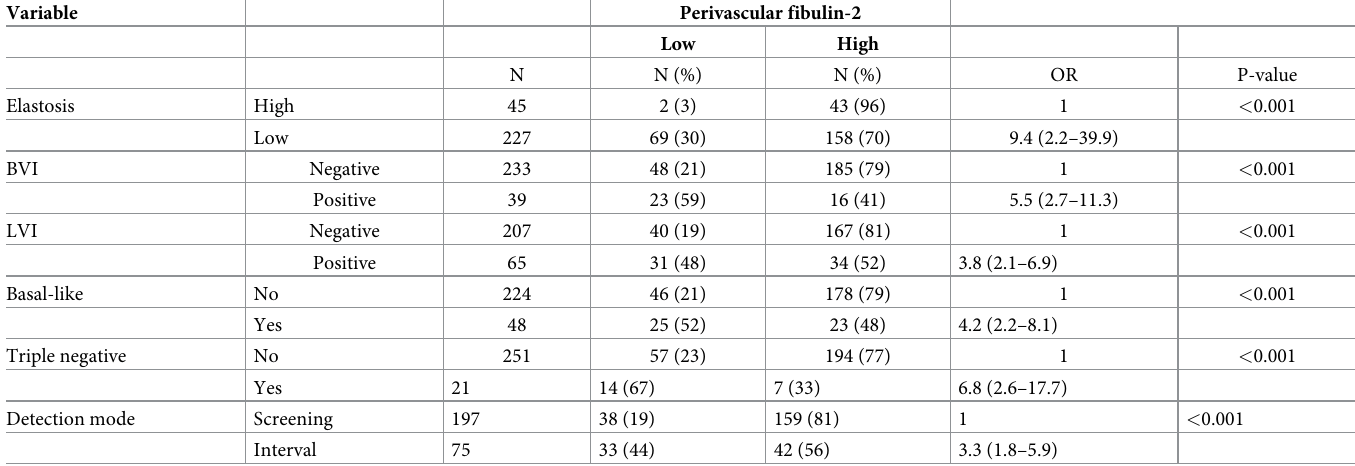
Table 2. Association between perivascular fibulin-2 expression and elastosis, vessel invasion, basal-like tumours, triple negative tumours as well as detection mode (n = 272). Variable